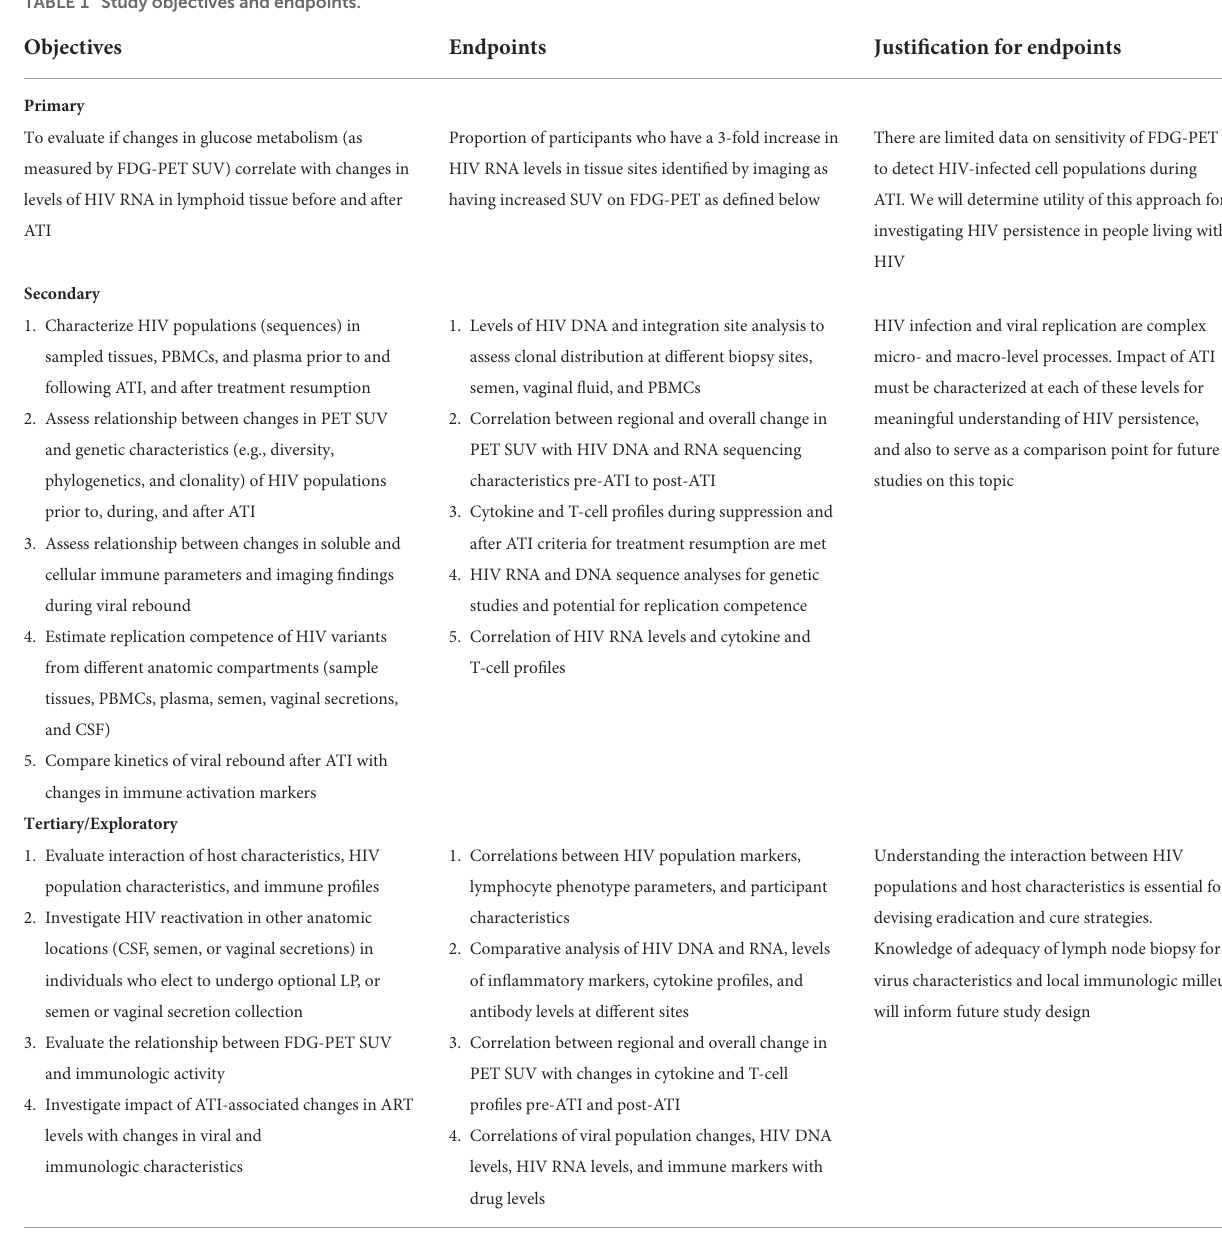
TABLE 1 Study objectives and